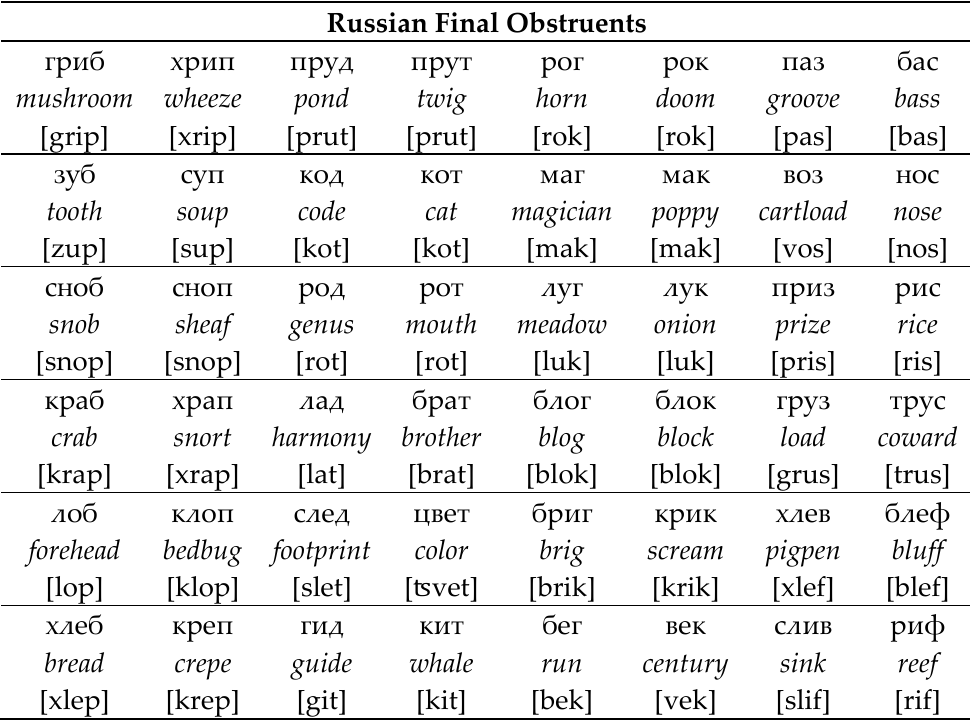
Table A4. Russian minimal pairs with voiced and voiceless obstruents in word-final position.